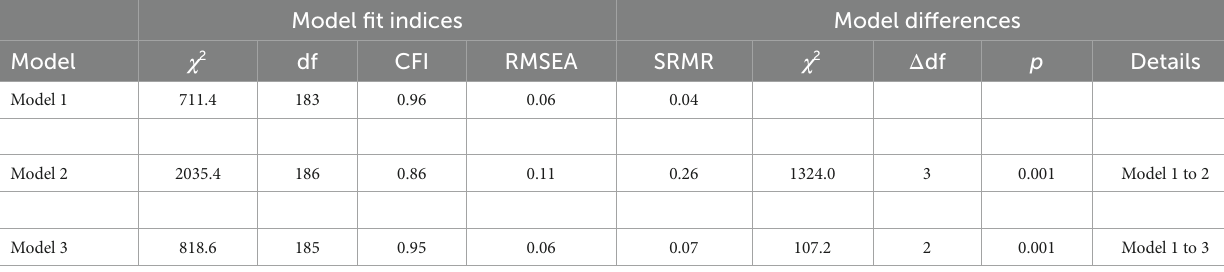
TABLE 1 Results of confirmatory factor